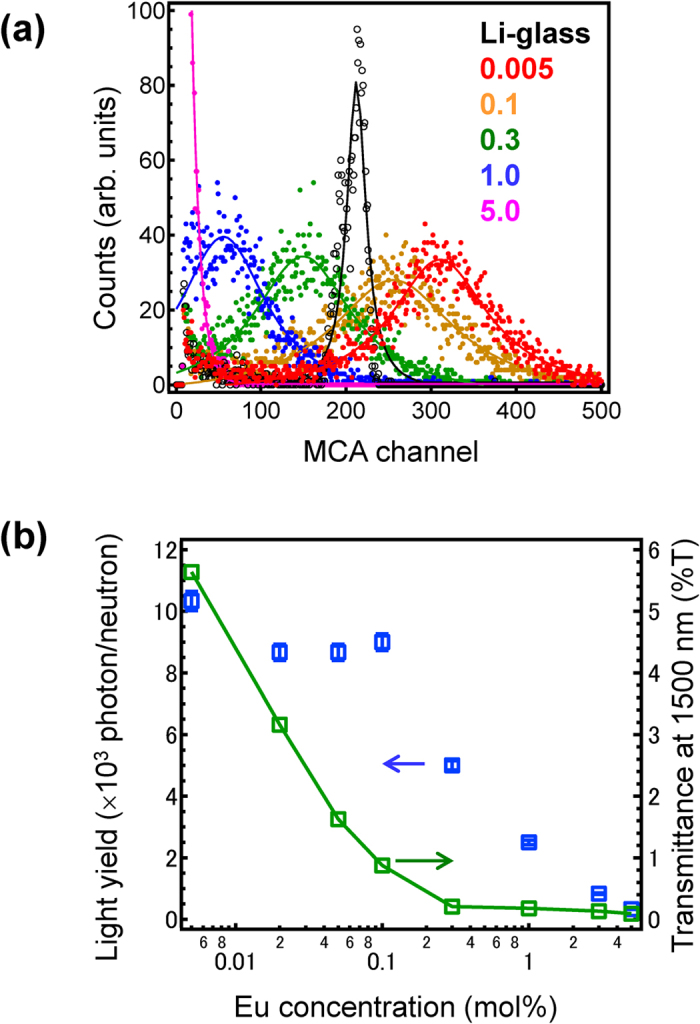
Neutron induced emission of Eu-doped 80LiF-20CaF2 eutectics.(a) Neutron excited pulse height spectra of LiF/CaF2 eutectics along with Li-glass as a reference. (b) 252Cf neutron excited light yield as a function of Eu concentrations together with that of non-doped sample. The transmittance is also shown as a right axis.